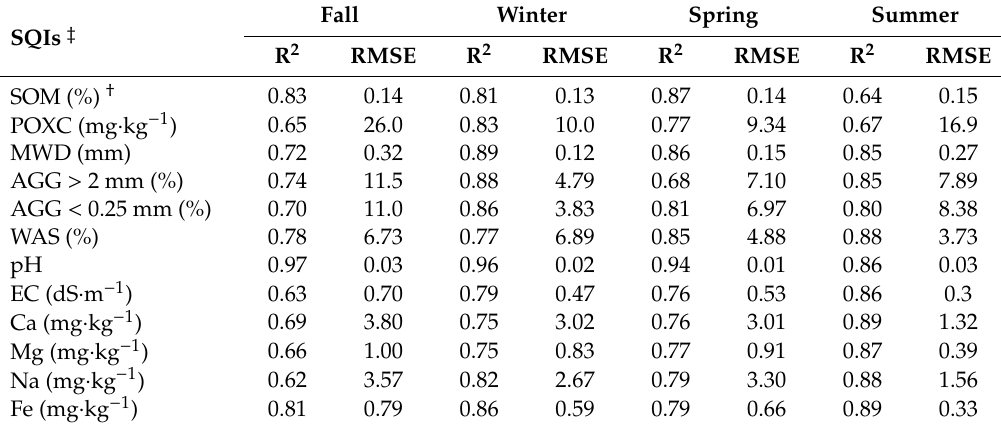
Table 8. Calibration R 2 and RMSE values for laser induced breakdown spectroscopy (LIBS) over four measurement seasons at Leyendecker Plant Science Center, Las Cruces, NM (n = 36 for each season). SQIs